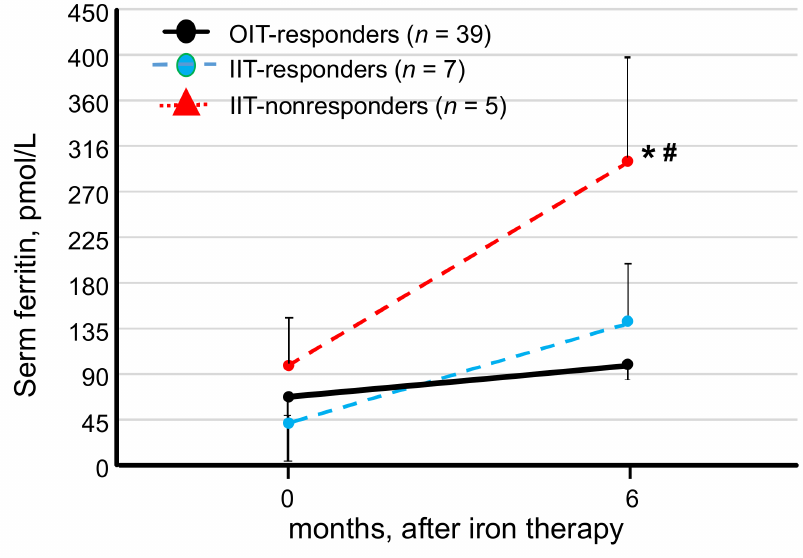
Figure 6. Change in serum levels of ferritin at 0 and 6 months after initiation of the study in OIT-responders, IIT-responders and IIT-nonresponders. Serum levels of ferritin were significantly higher in the IIT-nonresponders than in the OIT-responders and the IIT-responders, whereas there was no difference in serum ferritin levels between the OIT-responders and the IIT-responders. Comparison of three nonparametric data groups was analyzed by the Tukey–Kramer test. * p < 0.05, vs. IIT-responders, # p < 0.01, vs. OIT-responders.